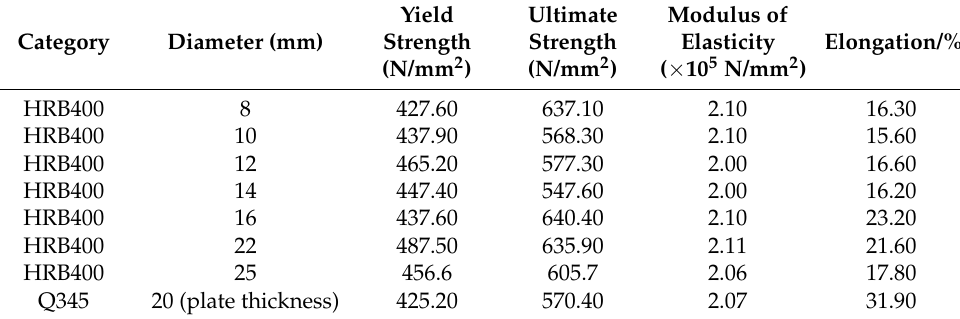
Table 4. Mechanical properties of steel bars and plates.